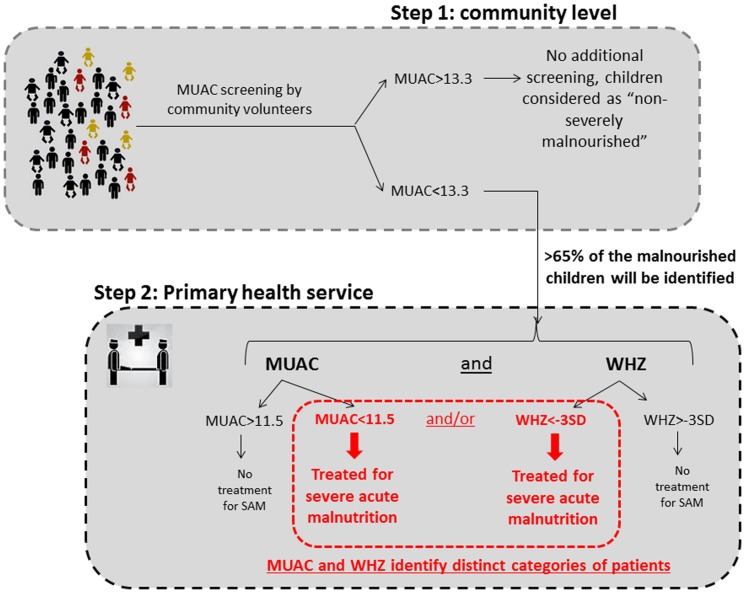
Two-step screening procedure for severe acute malnutrition at community level.